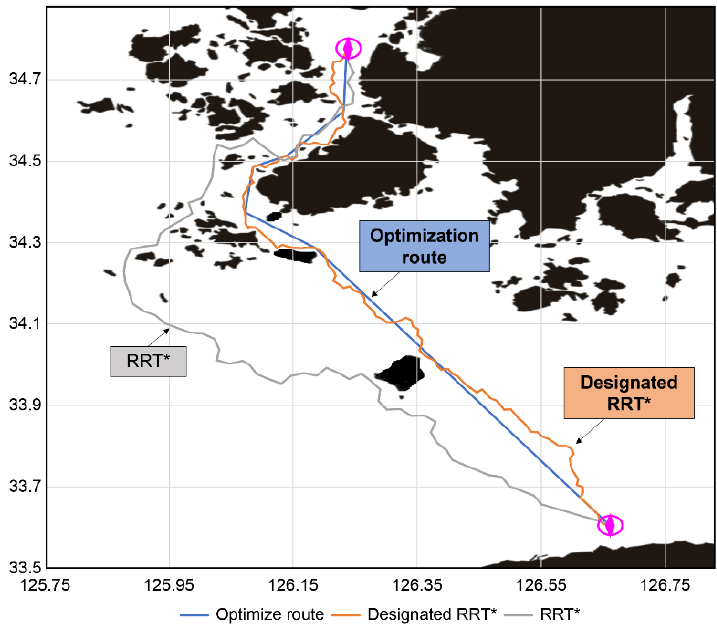
Figure 20. The route planning simulation results.